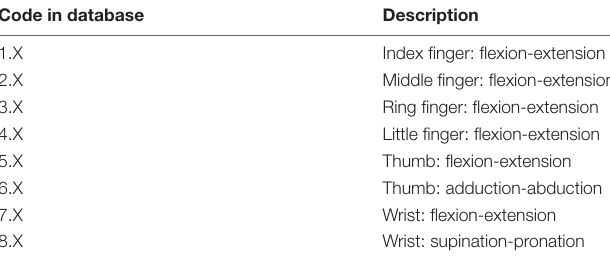
TABLE 1 | The subset of movement tasks utilized in the current